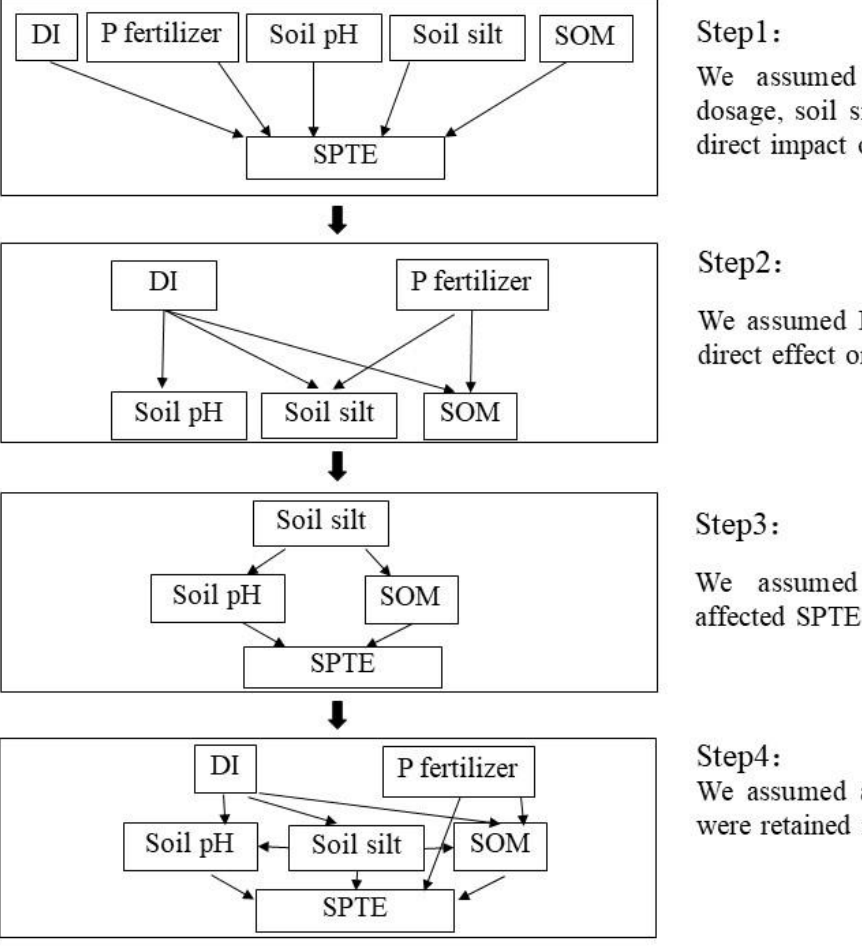
Figure A1. Schematic diagram for structural equation modeling (SEM). DI: drought index. SOM: soil organic matter, g·kg −1 . AK: available potassium, mg·kg −1 . SPTE: soil P transformation efficiency, mg·kg −1 .